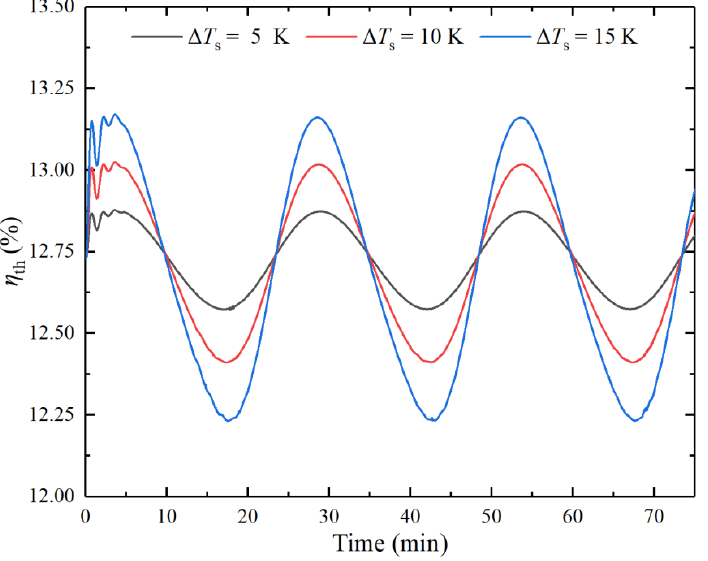
Figure 9. Relationship between the thermal efficiency and heat-source temperature.